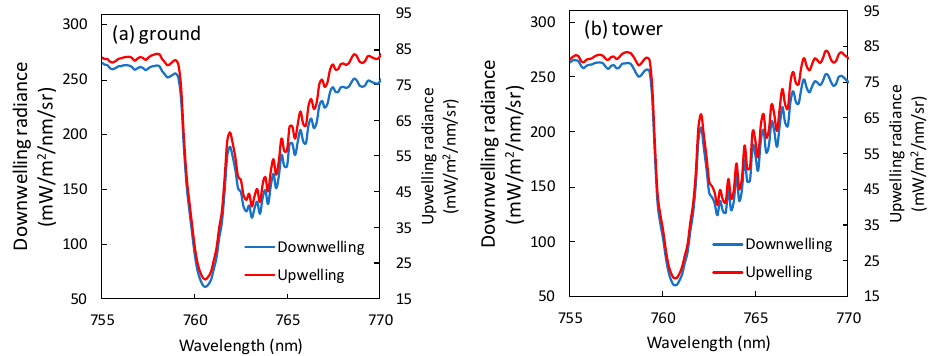
Figure 10. Downwelling and upwelling radiance at O 2 -A band measured on the ground and on the tower (without atmospheric correction) at 13:01 on 7 September 2018, at the Daman site.